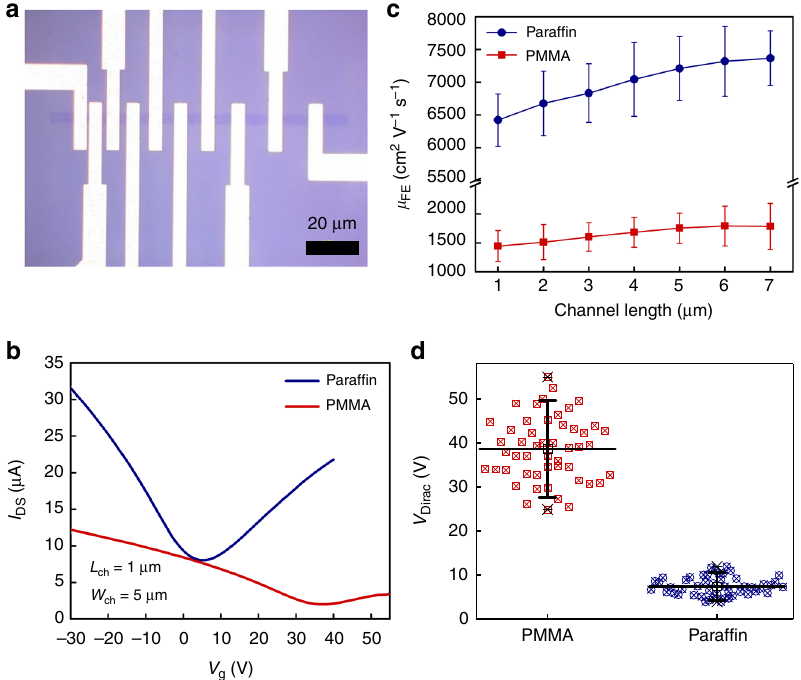
Fig. 3 Back-gate electrical measurement results of PMMA- and paraf fi n-transferred graphene devices. a Optical image of a typical graphene fi eld-effect transistors (FETs) array with increasing channel length. b Transfer characteristics comparison of two fi eld-effect transistors fabricated with PMMA- and paraf fi n-transferred graphene. The Dirac voltage of device fabricated on paraf fi n-transferred graphene is much smaller and closer to zero. c Two-terminal fi eld-effect (electron) mobility distribution of graphene FETs fabricated with PMMA- and paraf fi n-enabled transfer process as a function of channel length. Each average value was extracted from 10 graphene FETs. d Dirac voltage distribution of 100 graphene FETs fabricated with PMMA- and paraf fi n-assisted transfer. In b – d , error bars indicate standard deviations, blue-color round-shaped symbols represent paraf fi n-transferred graphene, and red-color square- shaped symbols represent PMMA-transferred